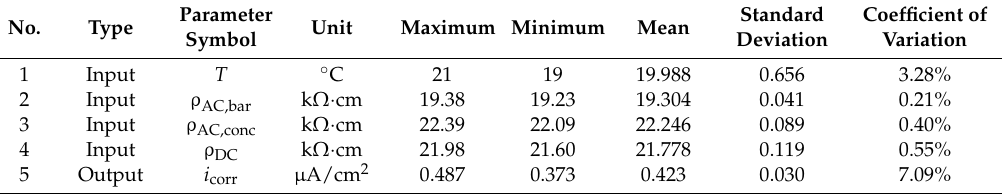
Table 2. Statistical characteristics of the database (based on data presented in [33]).